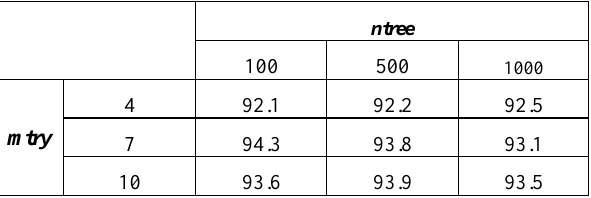
Table 3. RF hyperparameter tuning of mtry and ntree according to the overall accuracy (%) using grid search approach.